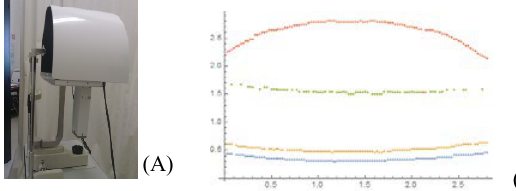
Fig. 1. (A) Slit-scanning tomography system. (B) Example of a mathematical adjustment for the calculation of biometric and optical properties of the anterior (blue) and posterior (orange) corneal surfaces and anterior (green) and posterior (red) crystalline lens